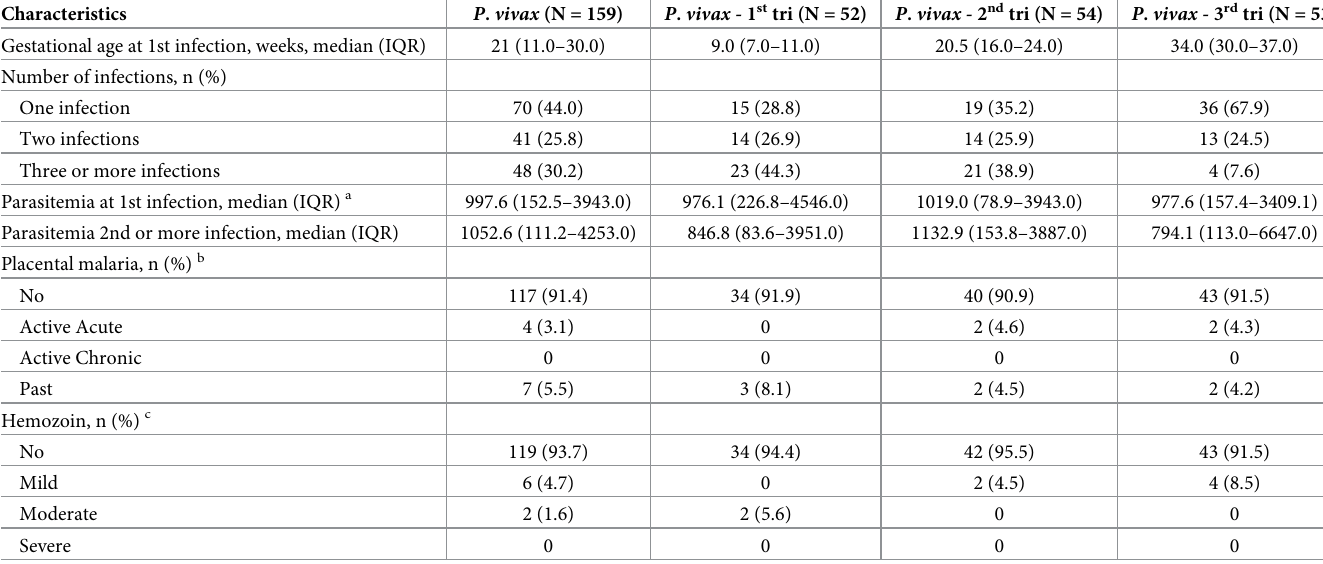
Table 3. Characteristics of the infection during pregnancy.